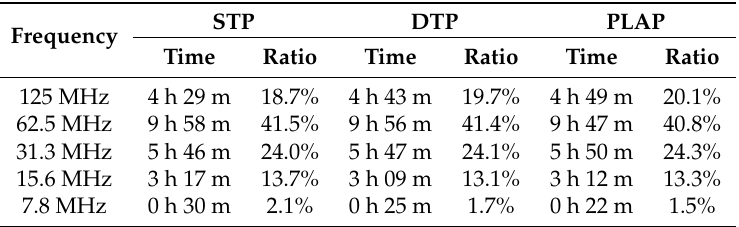
Table 5. Aggregate duration in each frequency mode. PLAP, packet loss-aware policy.